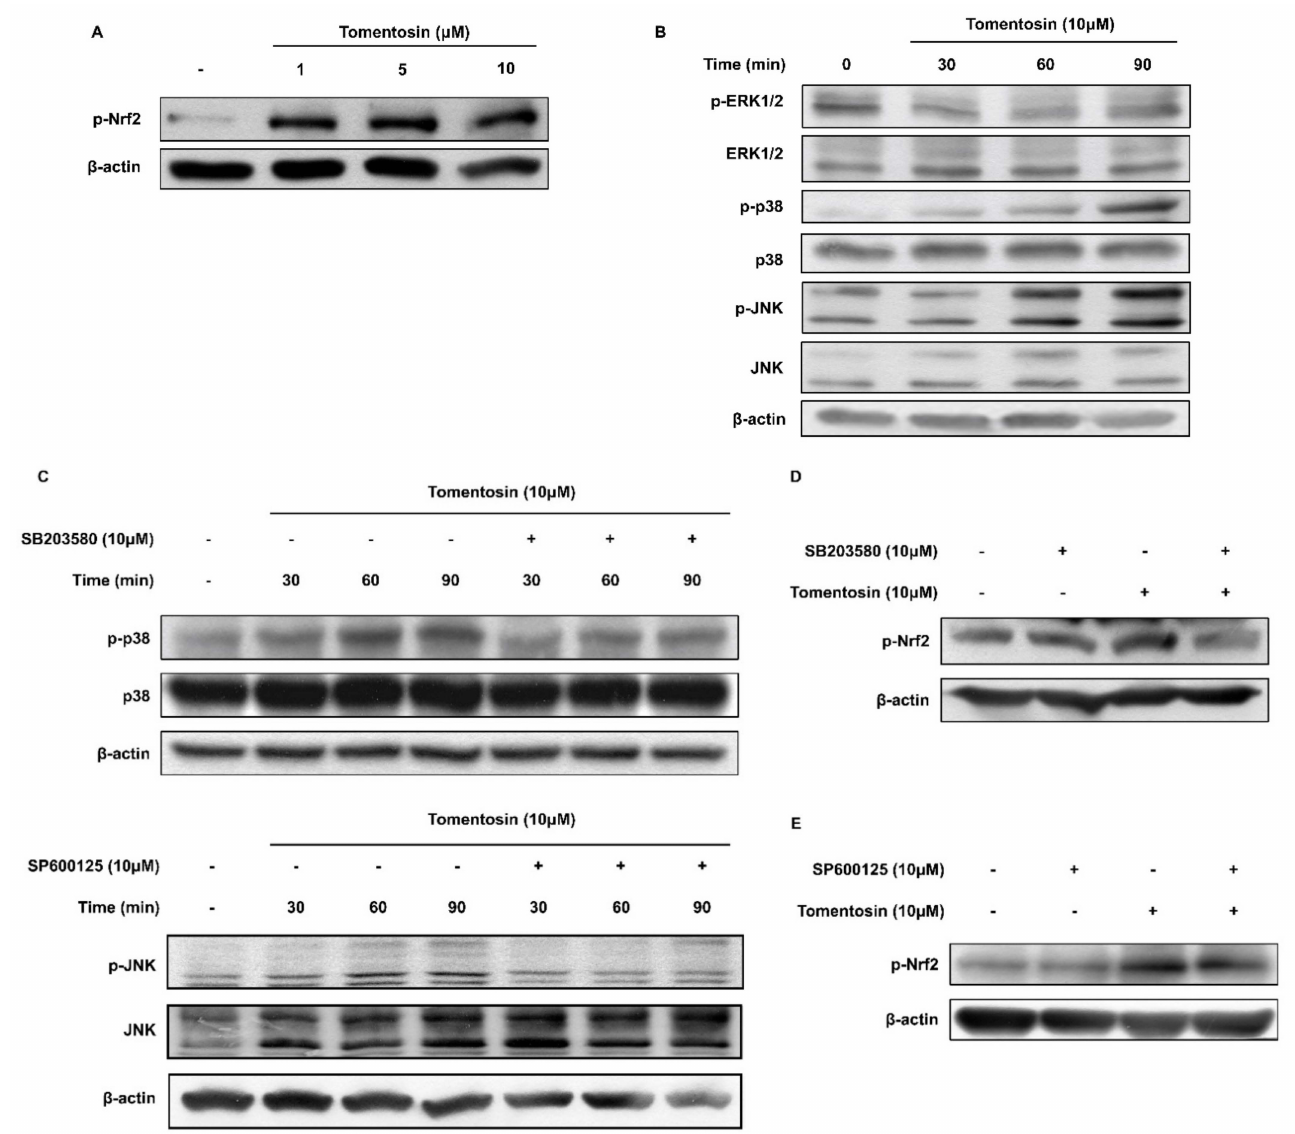
Figure 3. Tomentosin induces the phosphorylation of nuclear factor erythroid 2-related factor 2 (Nrf2) via the p38 and c-Jun N -terminal kinase (JNK) mitogen-activated protein kinase (MAPK) pathway. ( A ) HaCaT cells were incubated with 1, 5, or 10 µ M tomentosin for 24 h. The treated cells were then harvested and analyzed for Nrf2 phosphorylation by Western blotting. β -actin was introduced as the control for whole cell lysates. ( B ) Cells were treated with 10 µ M tomentosin for the indicated time periods (30–90 min). After the treatment period, the cells were collected and analyzed for the phosphorylation of extracellular signal-regulated kinase (ERK), p38 MAPK, and JNK by Western blotting. β -actin was introduced as the control for whole cell lysates. ( C ) Cells were treated with either 10 µ M SB203580 or 10 µ M SP600125 in addition to treatment with 10 µ M tomentosin for the indicated time periods (30–90 min). After the treatment period, the cells were collected and analyzed for the phosphorylation of JNK and p38 MAPK by Western blotting. β -actin was used as the control for whole-cell lysates. ( D , E ) Cells were co-treated with 10 µ M tomentosin and either ( D ) 10 µ M SB203580 or ( E ) 10 µ M SP600125 for 24 h. After 24 h, the cells were harvested and analyzed for the phosphorylation of Nrf2 by Western blotting. β -actin was introduced as the control for whole-cell